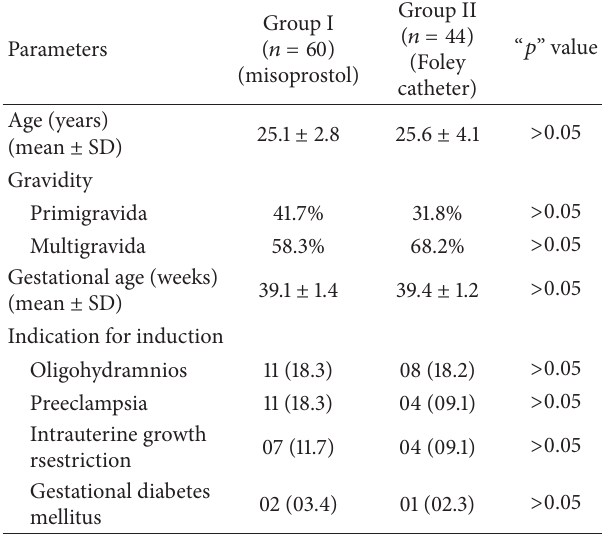
Table 1: Demographic profile and indication for induction.